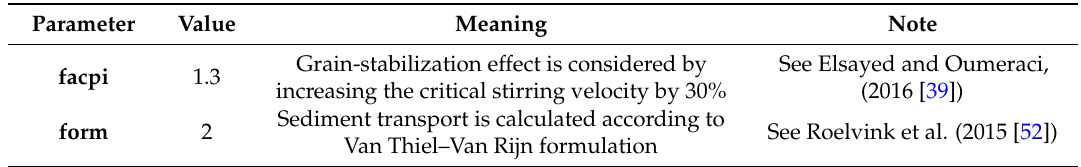
Table 3. Main parameters used in the analysis of the breach and the induced flooding at Het Zwin using